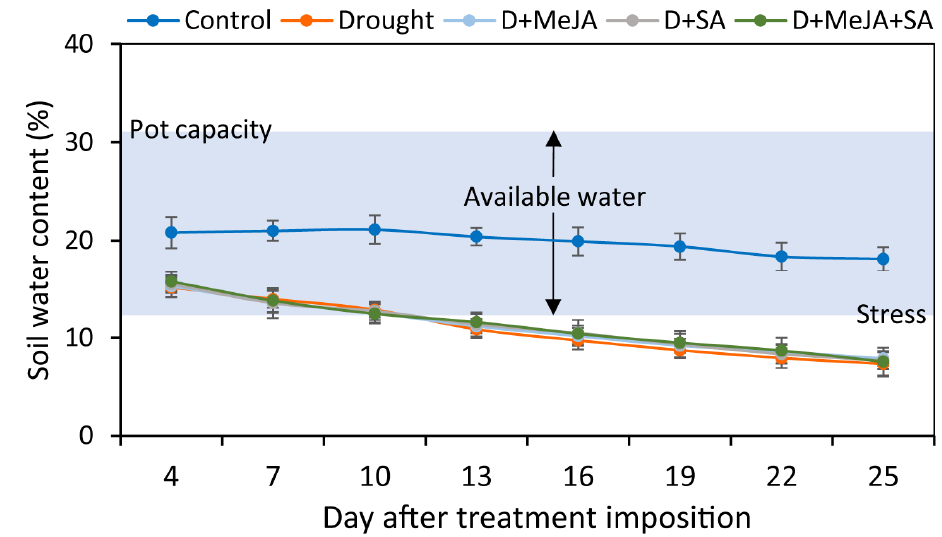
Figure 2. Soil water status of the control, drought (D), and drought-stressed plants treated with methyl jasmonate (D + MeJA), salicylic acid (D + SA), and their combination (D + MeJA + SA) throughout the experimental period. Soil water content was recorded daily for every pot. Each data point indicates the 3-day running average values across four replicates. Vertical bars represent +/− values of the mean. The experimental soil was silt loam (clay:silt:sand = 24:50:26) with a full pot water capacity of 30.6% volumetric soil water content. (Adapted from Pardossi et al. [52]; Weng and Luo [53]).